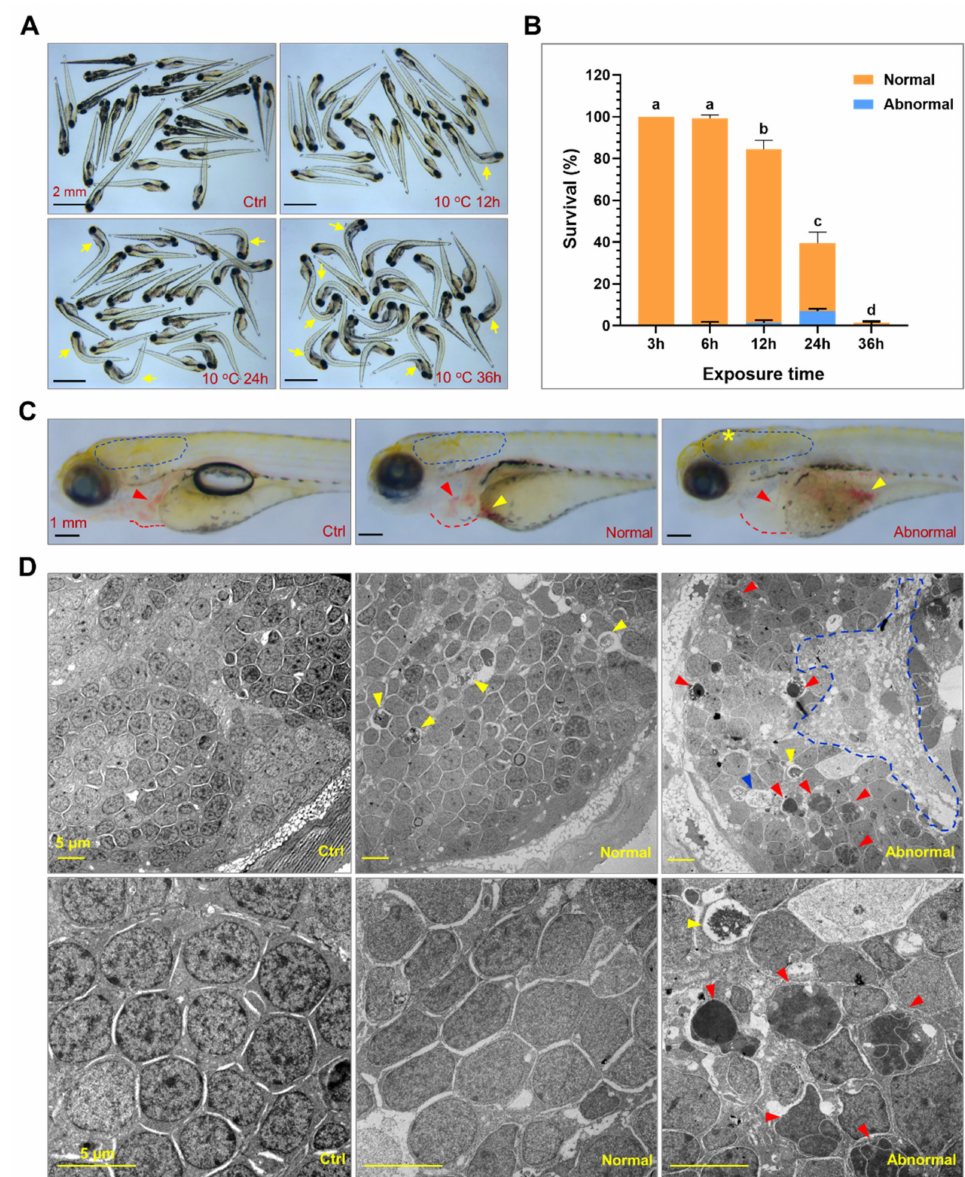
Figure 1. Exposure to lethal cold stress resulted in irreversible and systematic tissue damage. ( A ) Photos of zebrafish larvae exposed to 10 ◦ C for different time periods. The controls (ctrl) were the larvae developed to 120 hpf under 28 ◦ C. The yellow arrows indicate dead fish. ( B ) Survival rates of larvae under lethal cold stress. The larvae at 96 hpf were exposed to 10 ◦ C for indicated time periods. After recovered at 28 ◦ C for 24 h, the larvae were classified as normal and abnormal based on their morphologies and ability to swim. Different letters above the error bars indicate significant difference ( n = 4, p < 0.05). ( C ) Representative photos of the control, normal and abnormal larvae. The circles of dashed blue lines indicate brain. The red and yellow arrows indicate heart and red blood cells accumulated in the yolk sac. The yellow star indicates damage in the brain. The red dashed lines indicate border of pericardial cavity. ( D ) Transmission electron microscopy disclosed cold-induced cell death in the brain. The brain of zebrafish larvae (indicated by the dashed blue line circles in ( C ) was ultrathin-sectioned and imaged. The blue, red and yellow arrow heads indicate the cells undergoing necrotic, apoptotic and autophagic death, respectively. The circle of blue dashed line indicates area of necrosis. Photos of the lower panel are magnified regions of those of the upper